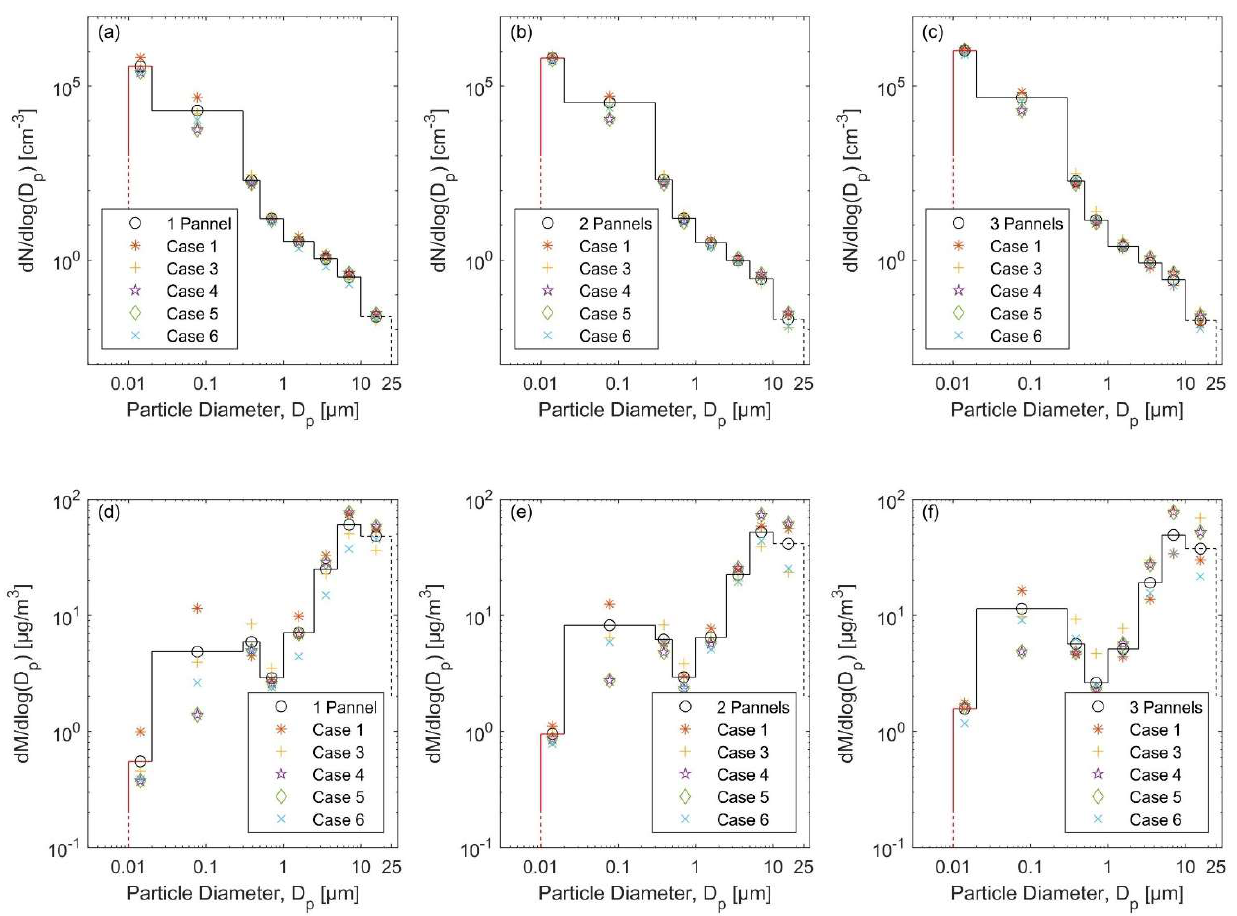
Figure 2. Particle number size distributions observed during the natural gas heater operation with ( a ) one panel, ( b ) two panels, and ( c ) three panels, and the corresponding particle mass size distribution ( d – f ).